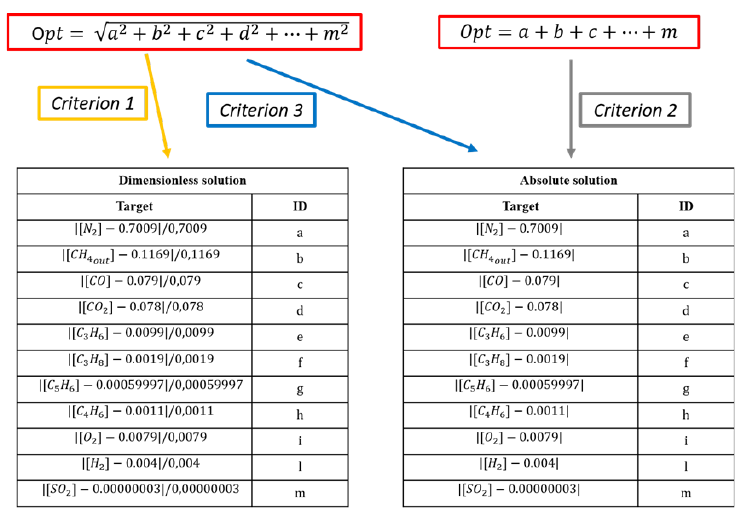
Figure 7. Example of application of CR.1, CR.2, and CR.3 adopted within the decision-making process.